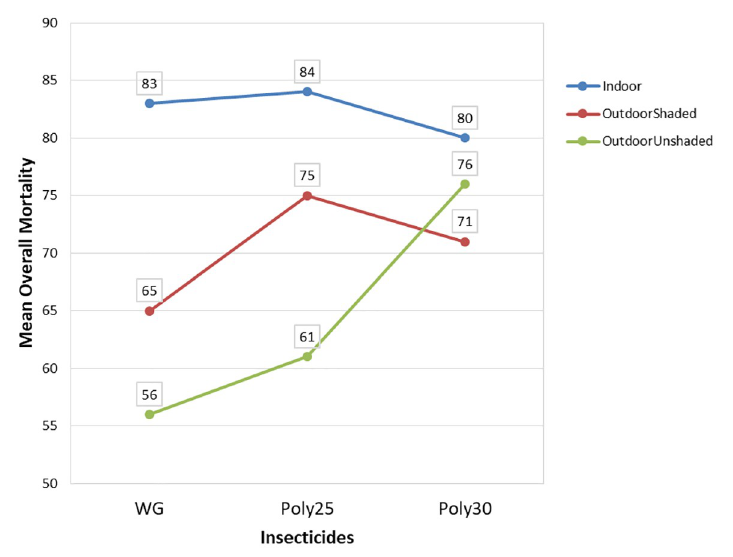
Fig 6. Average overall mortality based on insecticide and